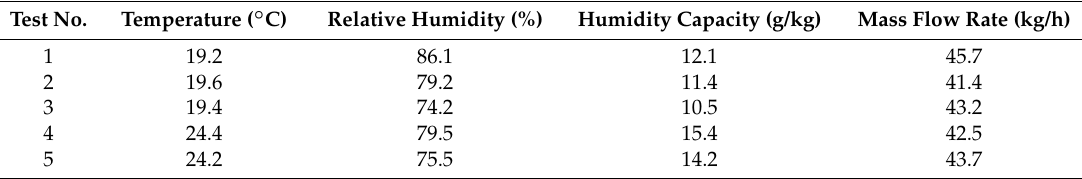
Table 2. Inlet air conditions for the experiments.